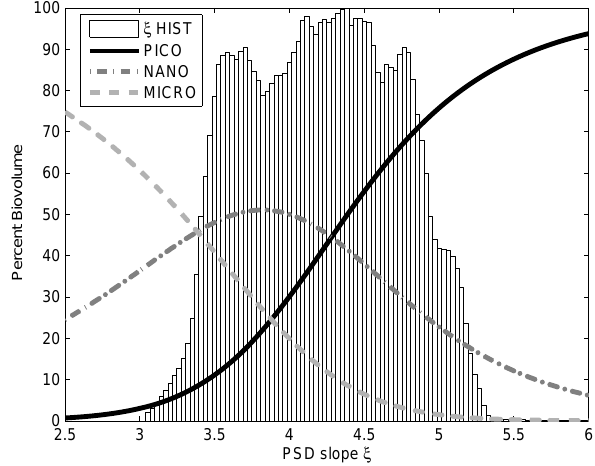
Fig. 1. The phytoplankton functional types (PFT’s), plotted as a function of the power-law slope of the PSD (Eq. 2). PFT’s are defined here as the percent volume contribution of three phyto- plankton size classes to total particle volume concentration in the phytoplankton-size range (here, 0.5 to 50µm). The three PFT classes are picoplankton (0.5 to 2µm in diameter), nanoplankton (2 to 20µm), and microplankton (20 to 50µm). The global histogram of the mean SeaWiFS-derived PSD slope ξ (Fig. 4c) is superim- posed to illustrate the range of geophysically occurring values of the PFT’s according to the PSD algorithm. The histogram counts are normalized by the number of observations in the highest count